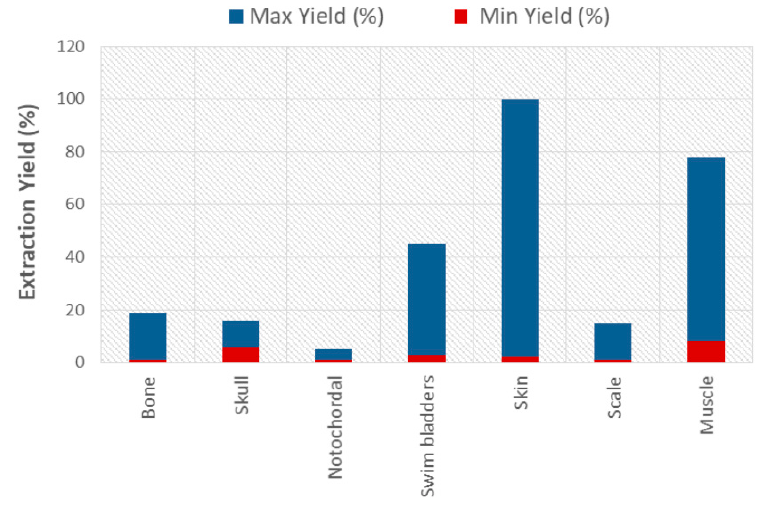
Figure 8. Yield of collagen obtained from fish sources [8].